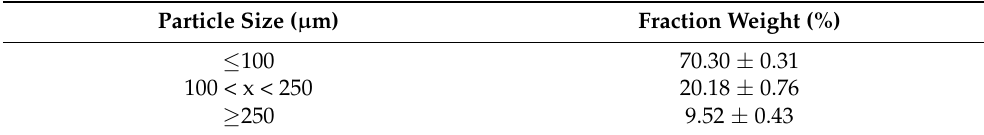
Table 2. Size distribution of the different carob flour